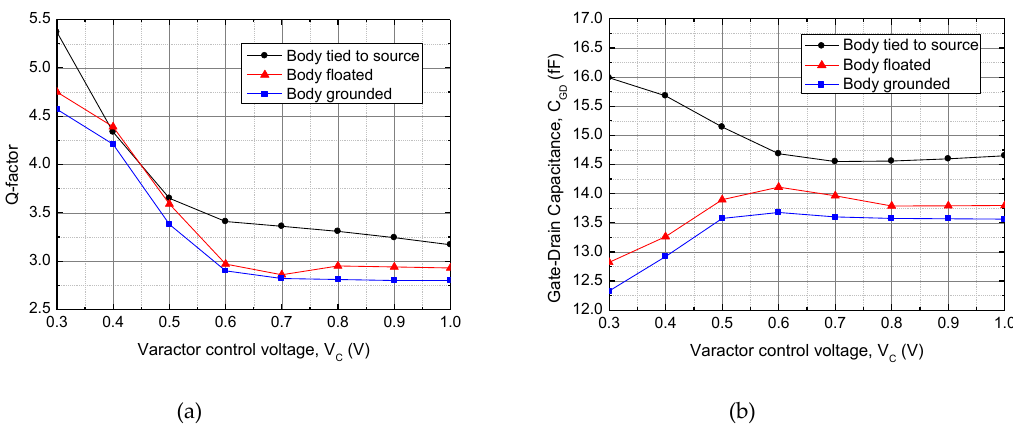
Figure 6. Simulation of MOS − varactors at 79 GHz: (a) Q-factor; (b) C gd .